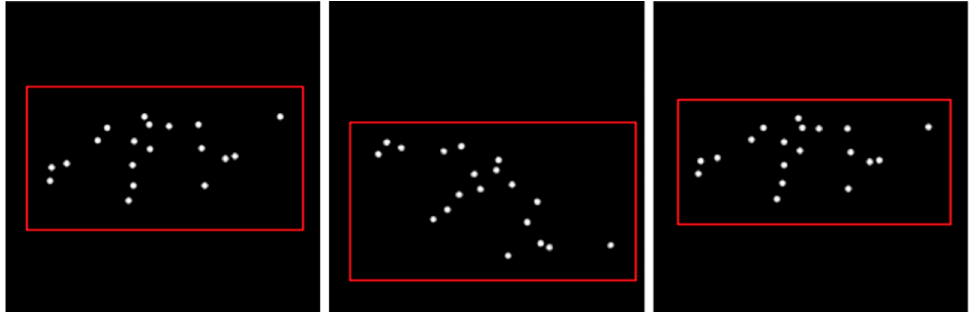
Figure 8. Bounding boxes, inferred from landmarks, used for training the wing detector.